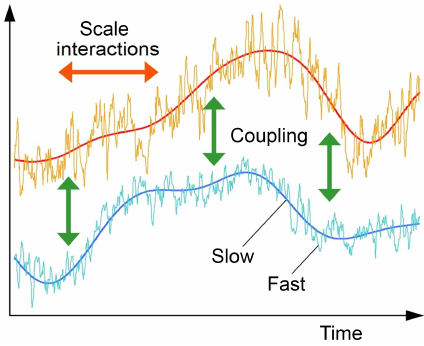
Figure 6. Co-evolution resulting from the interaction of a number of processes (at least two: one represents hydrological processes and the other landscape physical or ecological or social processes), each of which consists of fast and slow components producing emergent dynamics. Redrawn from Sivapalan and Blöschl